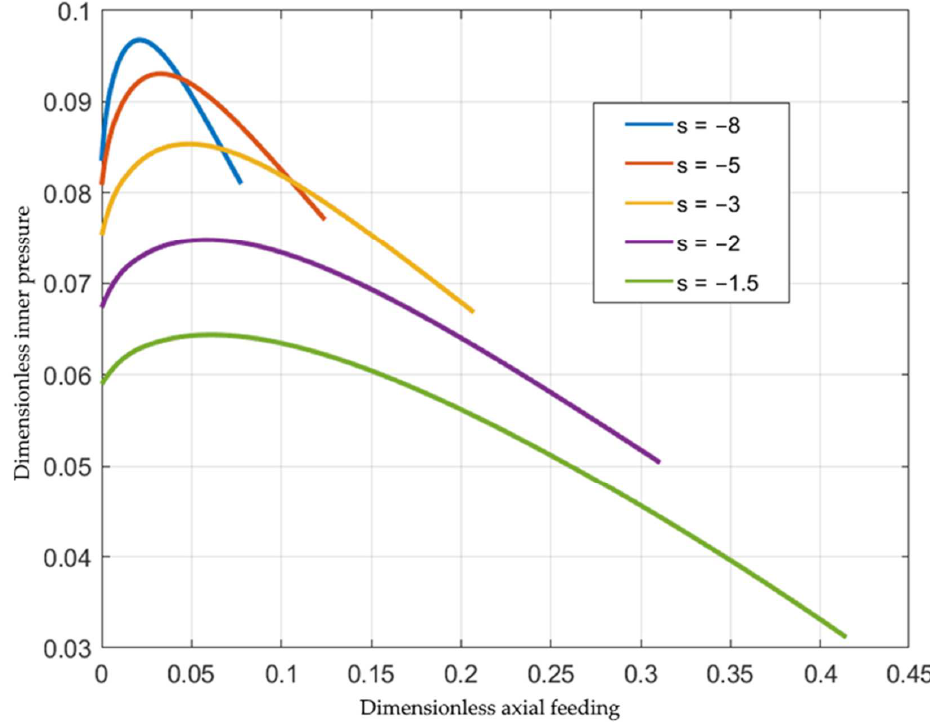
Figure 3. Variation of the inner pressure with the axial feeding for several loading paths.